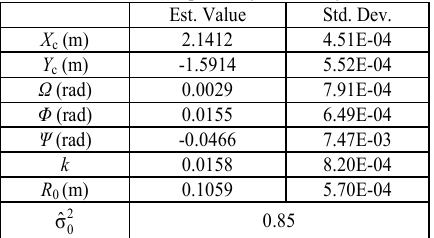
Table 9. Mean estimates of octagonal cone model fitting with the real data (Pole 4 - 5) captured by the Velodyne HDL-32E Est. Value